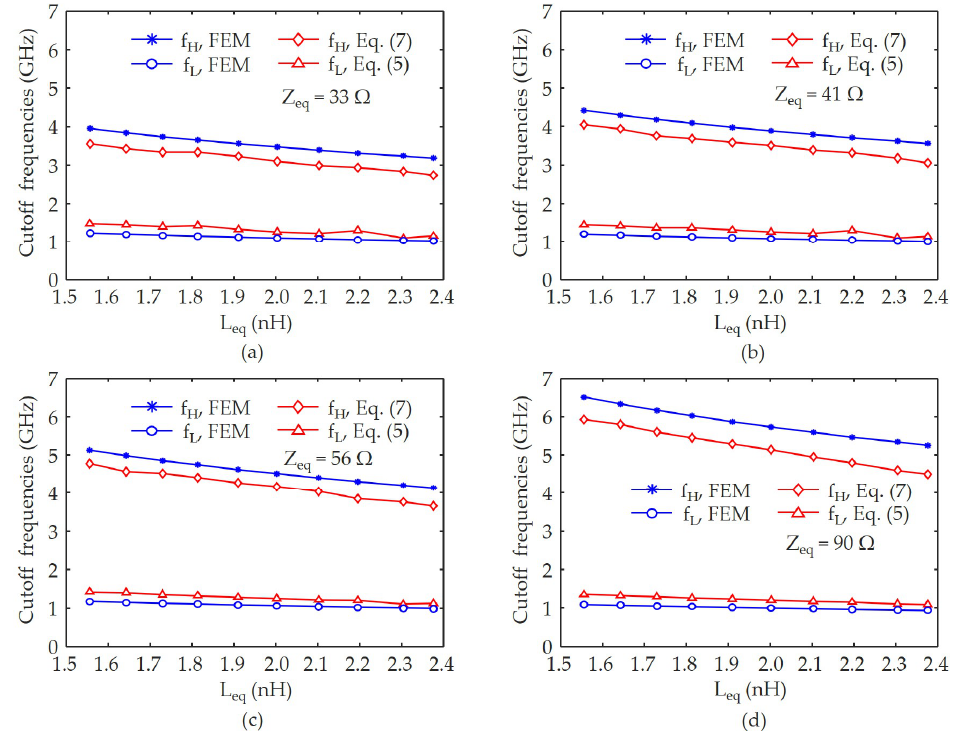
Figure 3. Various cutoff frequencies with respect to the changes of Z eq (( a ) 33 Ω, ( b ) 41 Ω, ( c ) 56 Ω and ( d ) 90 Ω ) and L eq used to examine the stopband characteristics and verify the closed-form expressions ( d ) 90 Ω) and L eq used to examine the stopband characteristics and verify the closed-form expressions for f L and f H for f L and f H .